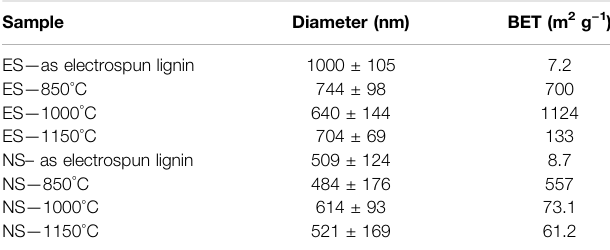
TABLE 1 | Fiber diameters and BET surface area results for the as-spun and carbonized ES and NS fi bers.